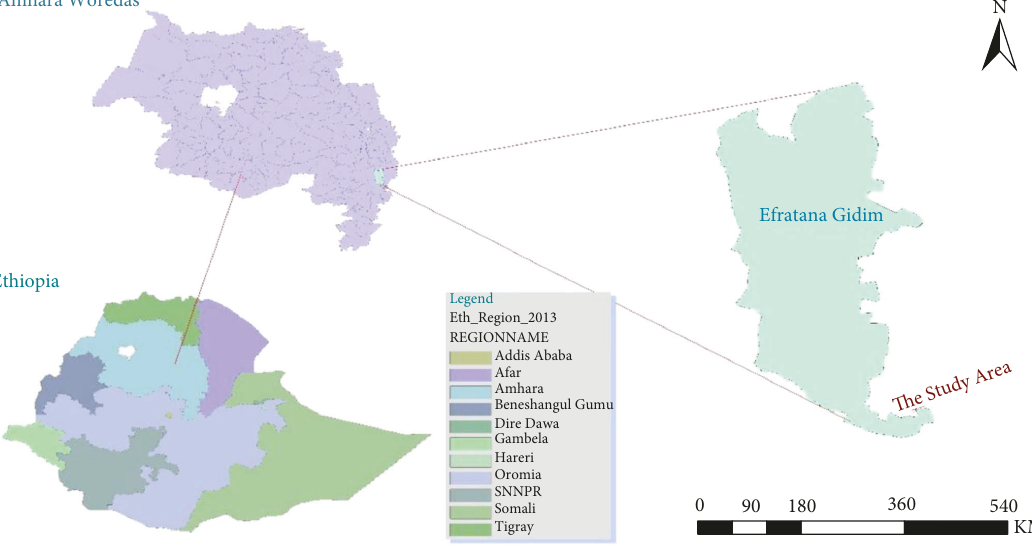
Figure 1: Location map of the study